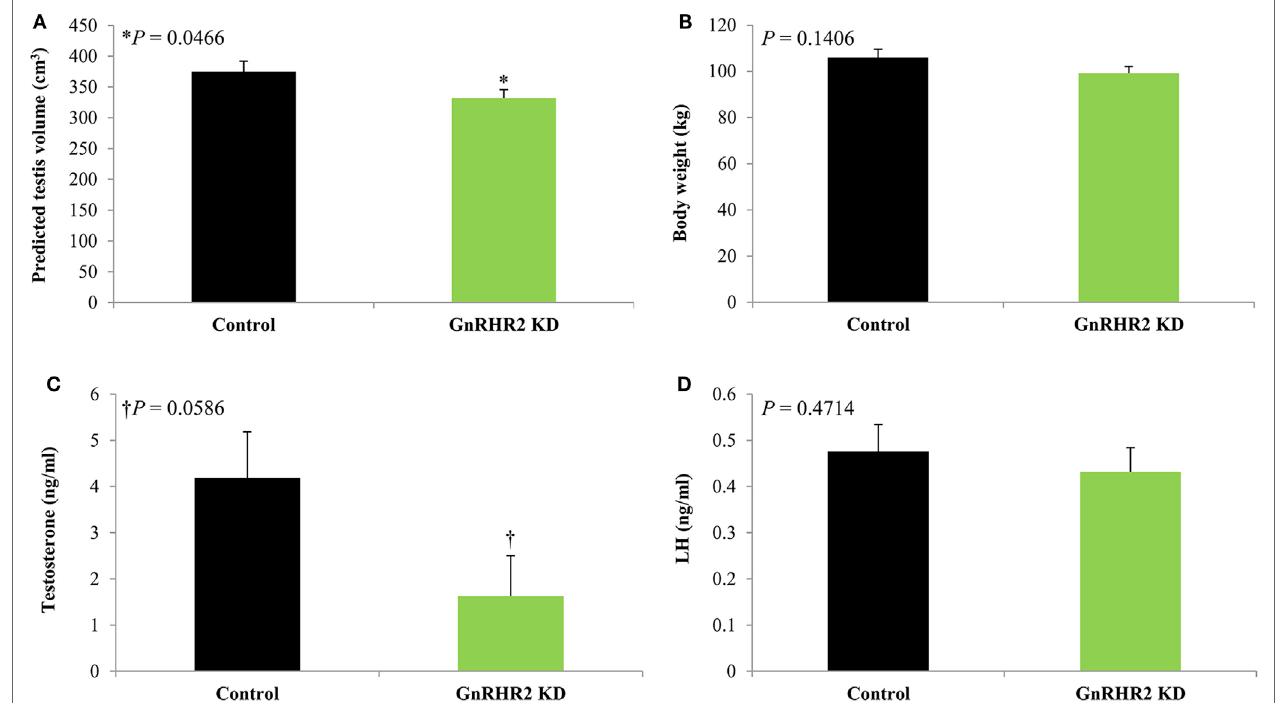
FiGURe 8 | GnRHR2 knockdown (KD) swine have smaller testes and reduced serum testosterone concentrations but similar body weights and circulating luteinizing hormone (LH) levels compared with littermate control animals during pubertal development. At 40, 100, 150, 190, 225, and 300 days of age, blood was collected from GnRHR2 knockdown ( n = 10) and littermate control ( n = 7) males; at the same time points, body weight and predicted testis volume were measured. Serum testosterone and LH concentrations were determined by radioimmunoassay. Data are presented as the Least Squares Means ( ± SEM). The P -value for the main effect of line is indicated. (A) Predicted testis volume, (B) body weight, (C) serum testosterone concentrations, and (D) serum LH concentrations. Adapted from Desaulniers et al. (53); no permission is required from the copyright